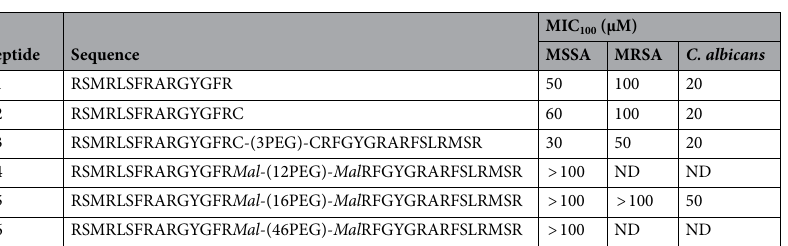
Table 1. Antimicrobial activity against S. aureus and C. albicans of dimeric forms of Ctl. MSSA (strain 49775) and MRSA (strain S1); C. albicans, (ATCC 10231TM). ND, not determined.